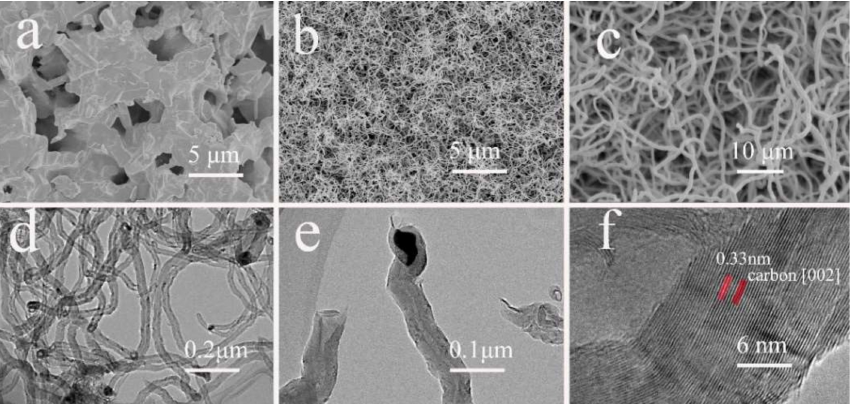
Figure 1. The characterization of the mullite-CNTs composite membrane. ( a ) scanning electron microscopy (SEM) image of original mullite ceramic substrate; ( b ) low magnification SEM image